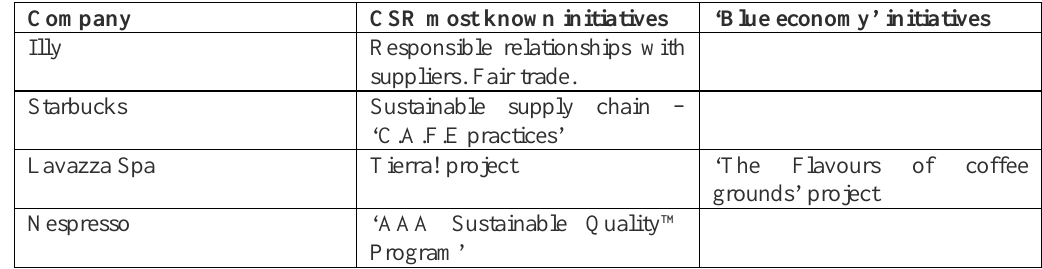
Table 2: Major coffee roasters attempts in sustainable development Company CSR most known initiatives ‘Blue economy’ initiatives Illy Responsible relationships with suppliers. Fair